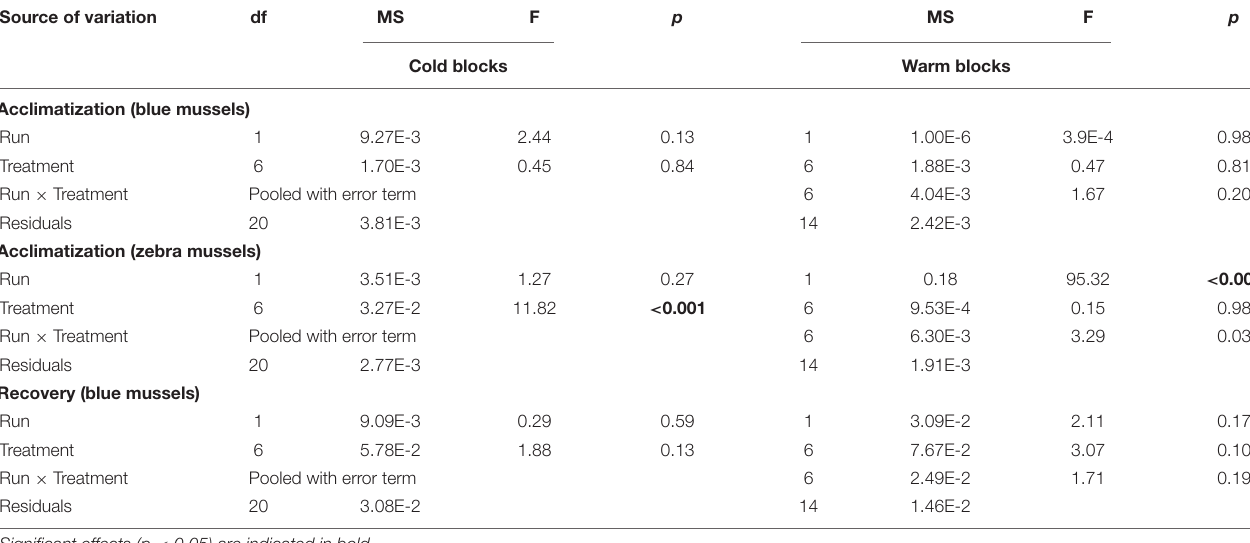
TABLE 2 | Results of two-way factorial ANOVAs evaluating the effect of treatments on the filtration activity of blue mussels ( Mytilus edulis ) and zebra mussels ( Dreissena polymorpha ). Source of variation df